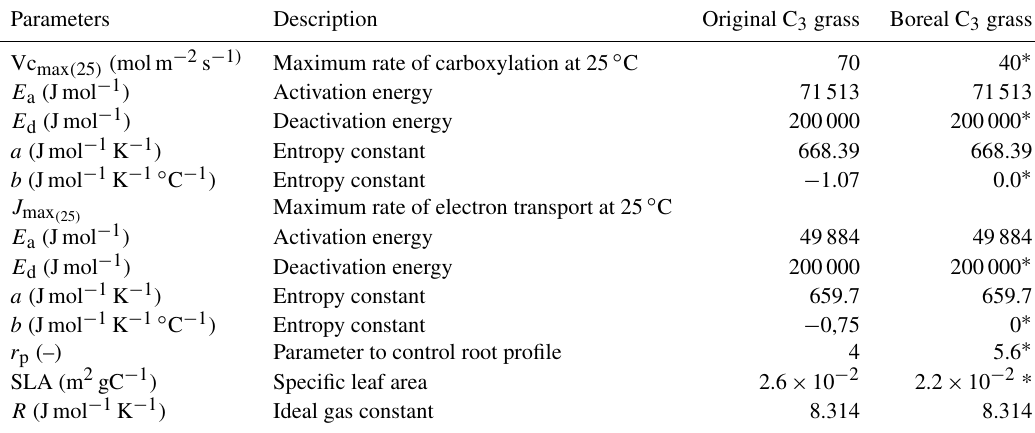
Table 5. Boreal C 3 grasses parameters.